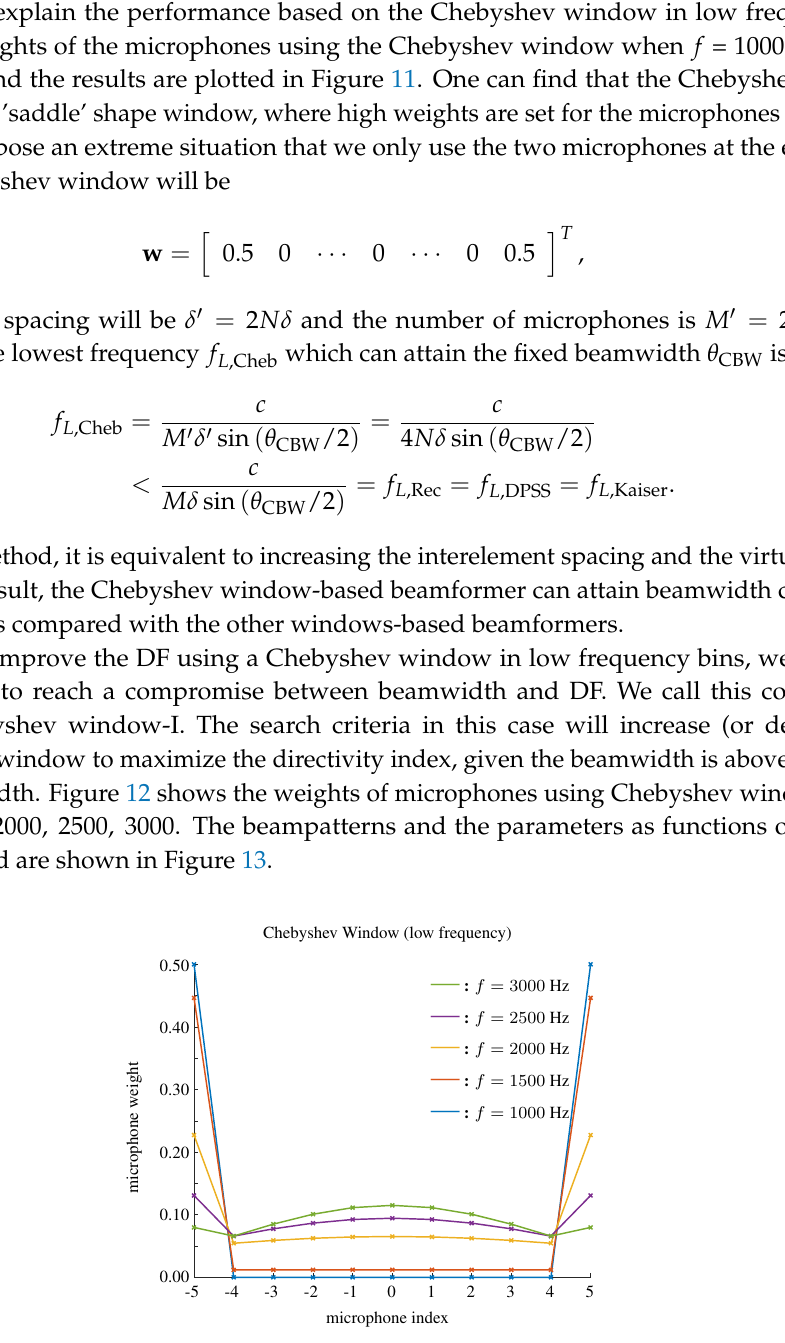
Figure 11. The weights of microphones for low frequency bins using the Chebyshev window, M = 11, δ = 3.5